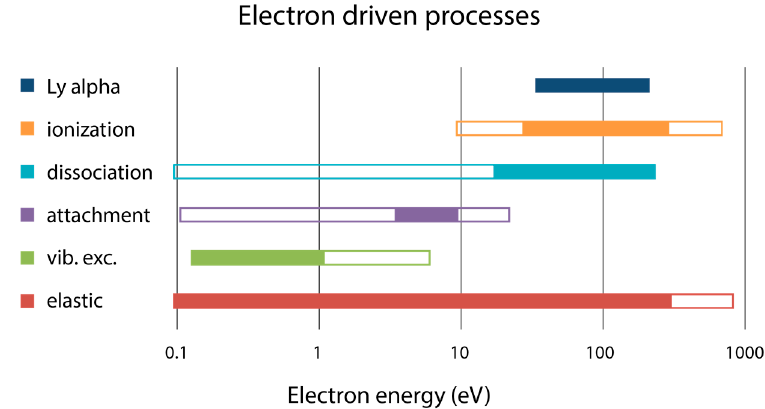
Figure 1. Electron energy ranges that correspond to the relevant processes in collisions with atoms and molecules. Full colour corresponds to the specific case of water (data taken from Itikawa and Mason [3]) while the open bars are extended ranges that correspond to the majority of atomic species: red, elastic scattering; green, vibrational excitations; violet, attachment; blue, dissociation; orange, ionization; darkblue, Lyman alpha.